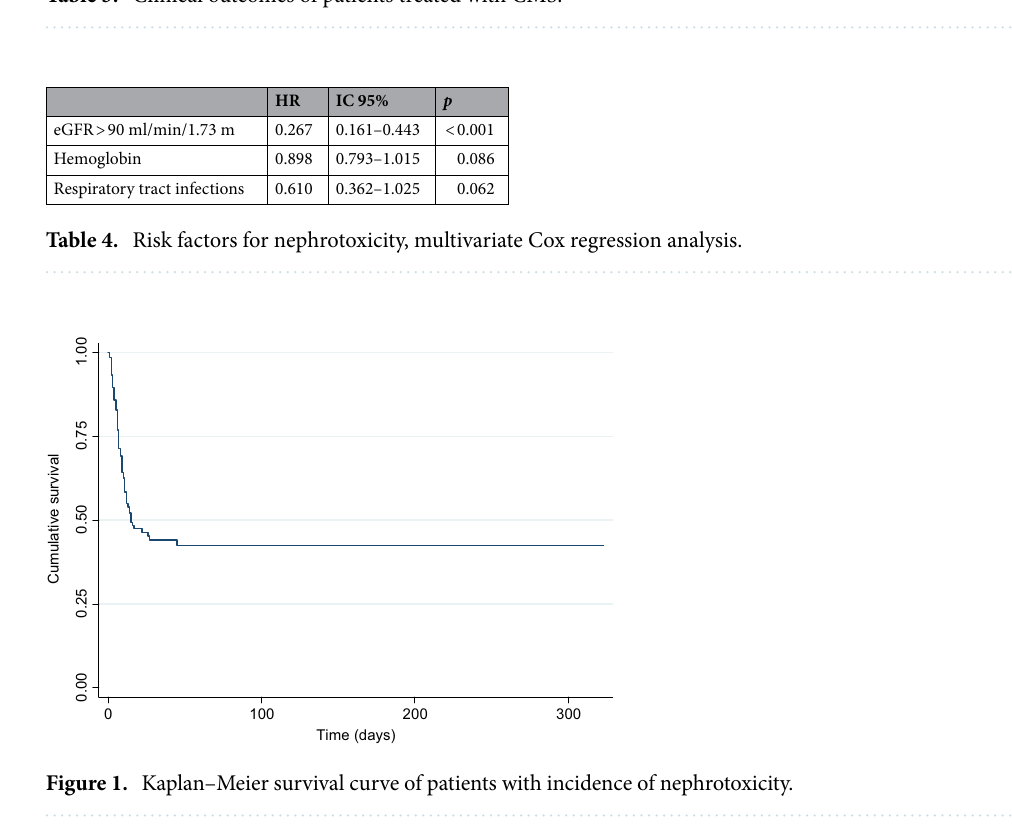
Table 3. Clinical outcomes of patients treated with CMS.